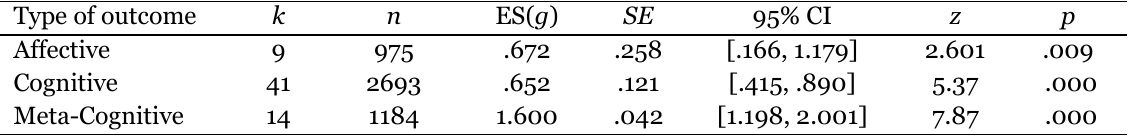
Effects of Scaffolding by Learning Outcome Type of outcome k n